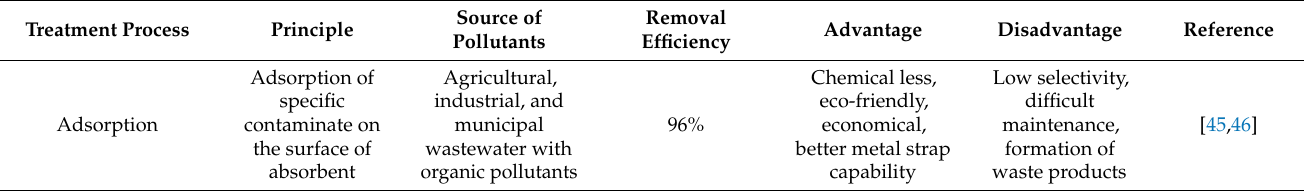
Table 1. Comparison of different wastewater treatment process for pollutant removal from wastewater. Treatment